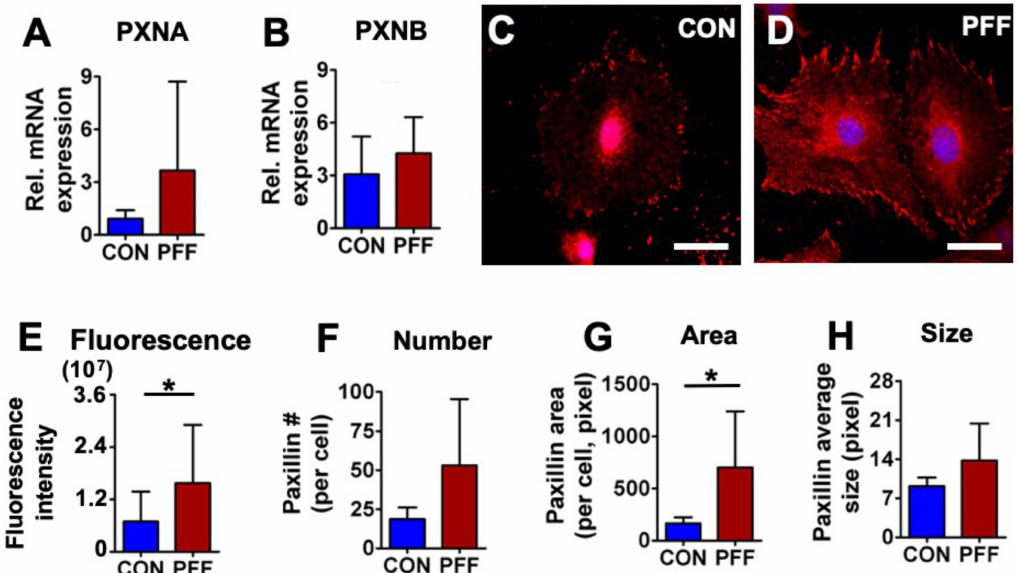
Figure 4. E ff ect of 1 h PFF on paxillin expression and distribution in MC3T3-E1 osteoblasts. ( A ) mRNA expression of PXNA . ( B ) mRNA expression of PXNB . ( C ) 2D images of control cells stained for paxillin (red) and DAPI for the nucleus (blue). ( D ) 2D images of 1 h PFF-treated cells stained for-paxillin and nucleus. Bar = 40 µ m. ( E ) Fluorescence intensity of paxillin in control and PFF-treated cells. ( F ) Paxillin number in control and PFF-treated cells. ( G ) Paxillin area in control and PFF-treated cells. ( H )